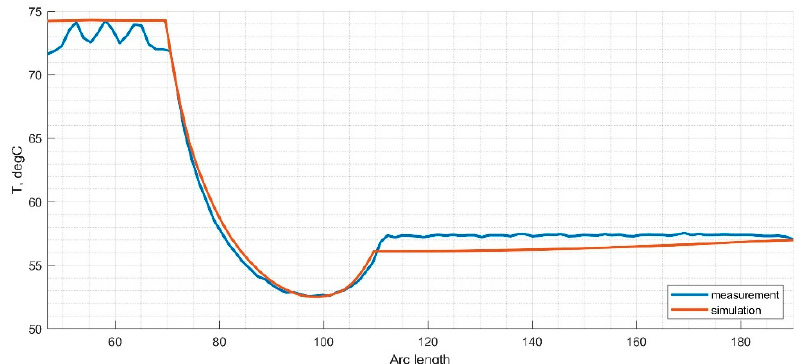
Figure 5. Temperature values measured (in blue) and calculated using the numerical model (in red) along the edge of the lamp on its surface established after 8 h of operation.